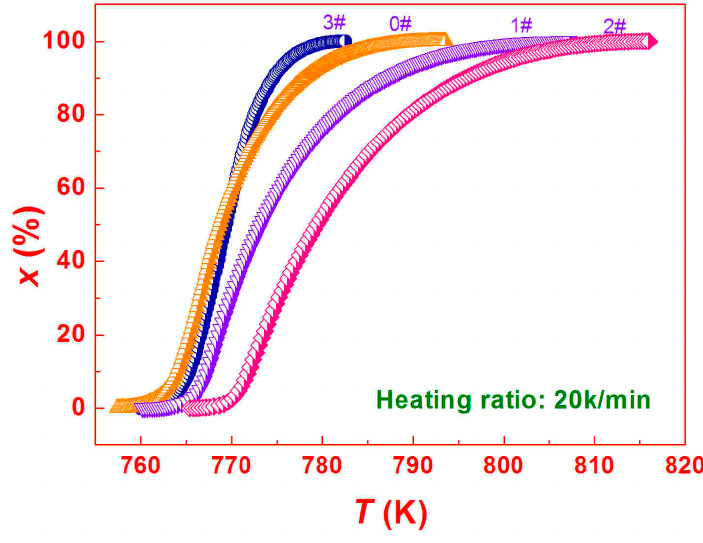
Figure 5. Crystallization volume fraction x vs. temperature T for the BMG matrix and welds processed with different currents.